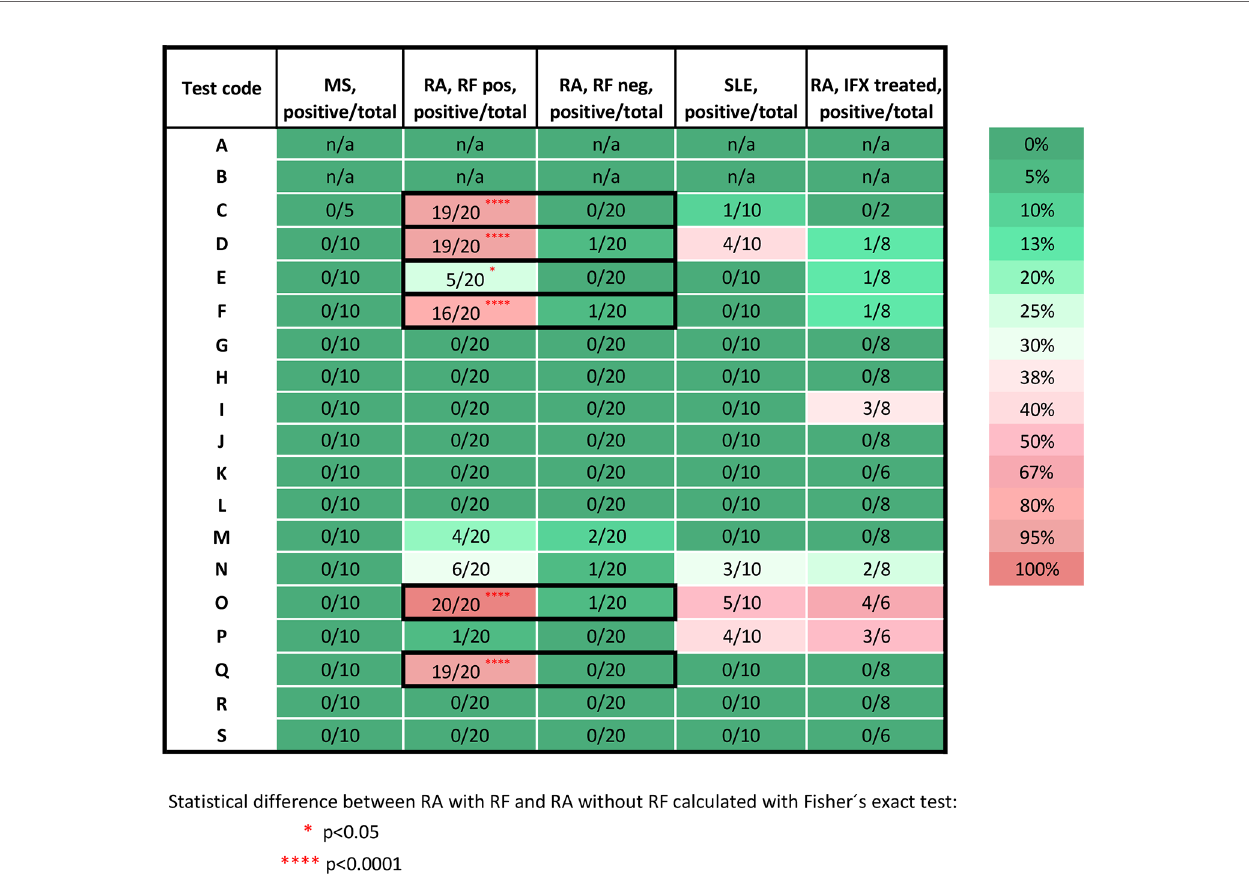
FIGURE 2 | Percentage of the false positive test results for IgM antibodies against SARS-CoV-2. Samples from MS patients (n=10), DMARD naïve RF positive RA patients (n= 20), RF negative (n=20) RA patients, SLE patients (n=10), in fl iximab treated RA patients (n=8). The test code keys are described in Table 2 . Stars indicate signi fi cant difference between RF status in RA patients, using Fisher exact test, *p < 0.05, ****p < 0.0001. Pos, positive; neg, negative; n, number; RF, rheumatoid factor; IFX, in fl iximab; n/a, not applicable; RA, rheumatoid arthritis; MS, multiple sclerosis; SLE, systemic lupus